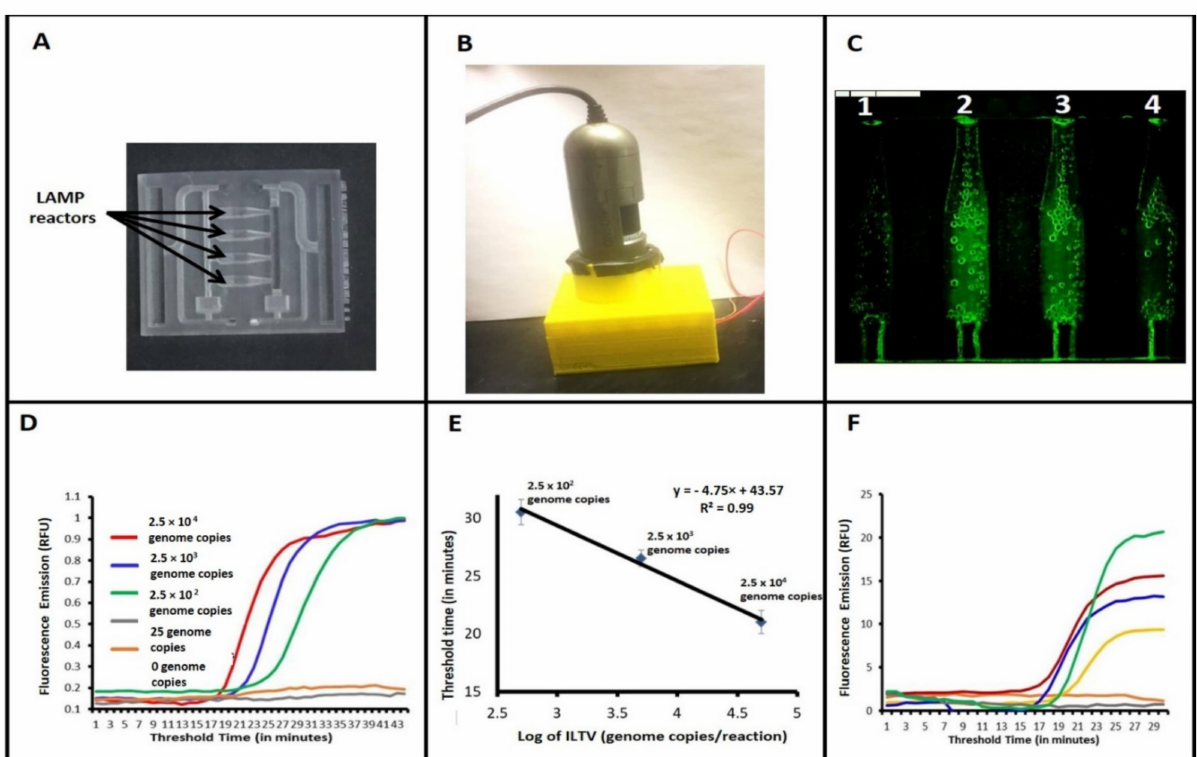
Figure 2. ( A ) A 3D-printed microfluidic chip with four multifunctional reactors for real-time LAMP reactions. ( B ) The portable fluorescent microscope monitors fluorescent emission from the microfluidic chip. ( C ) Image of fluorescing LAMP reactors (1: negative control; 2, 3, 4: Positive ILTV samples). ( D ) Real-time amplification curves of microfluidic chip-based ILTV LAMP assays with, 2500, 250, 25, 0 genome copies per reaction. ( E ) The microfluidic chip-based LAMP threshold time Tt (minutes) as a function of the log of ILTV concentration, ( n = 3). ( F ) LAMP amplification curves when testing clinical samples with the microfluidic